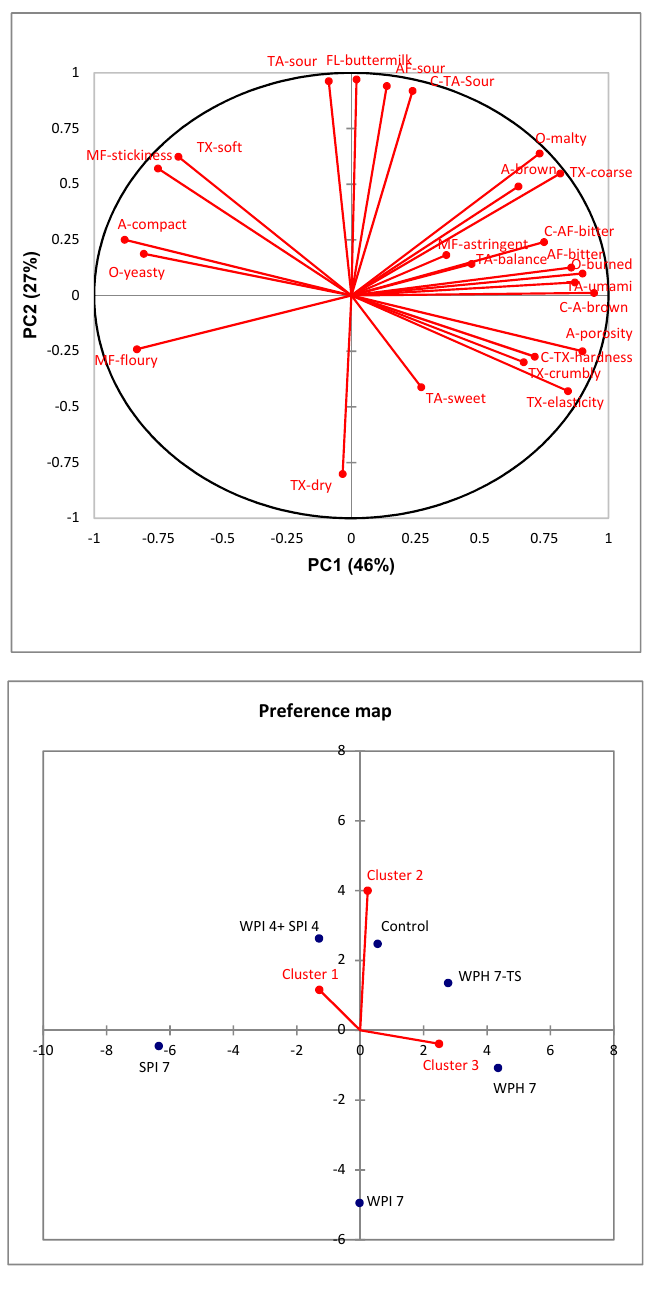
Figure 3. External preference mapping of rye bread. Red labels: O = odor attributes; A = appearance attributes; TA = taste attributes; TX = texture attributes; FL = flavor attributes; MF = mouthfeel attributes; AF = after ‐ taste attributes. Blue labels: numbers indicate amount of added protein (4 = 4%, and 7 = 7%); TS = texture and taste ‐ modified samples.